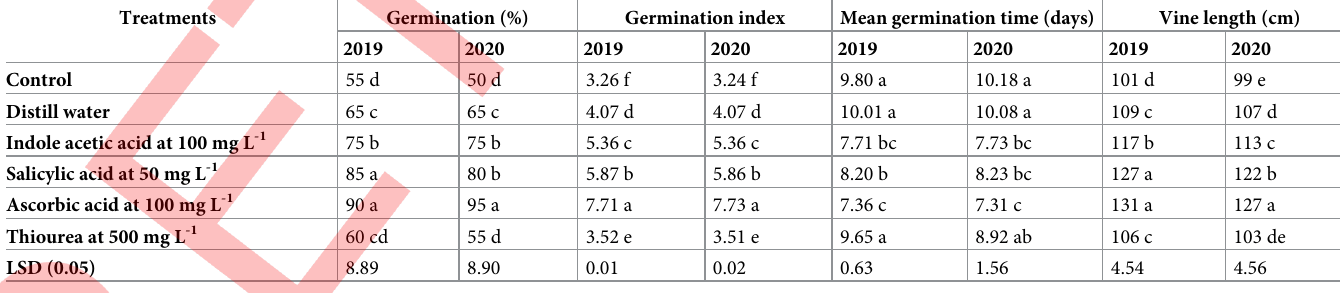
Table 2. The influence of seed priming with different growth regulators on seed germination, germination index, mean germination time, and plant height of Indian squash under field conditions. Treatments